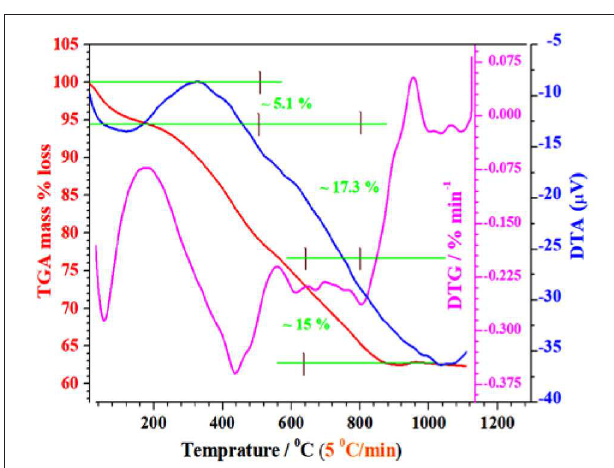
FIGURE 2 | TG/DTA data of xerox gel form precursors. TG-DTA, thermogravimetric/differential thermal